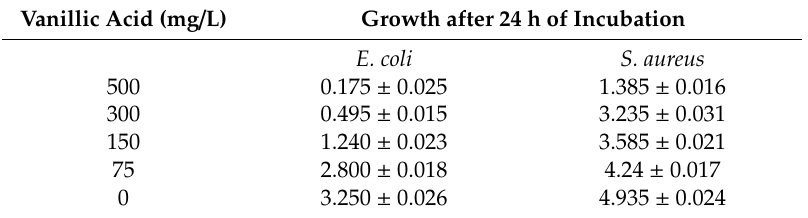
Table 3. Minimal inhibitory concentration (MIC) of vanillic acid (taken as a target bioactive molecule) vs. E. coli and S. aureus . Strain growth is reported as turbidity in the McFarland scale. Values represent the di ff erence between the turbidity measured after 24 h of incubation at 37 ◦ C and that detected at the beginning of the